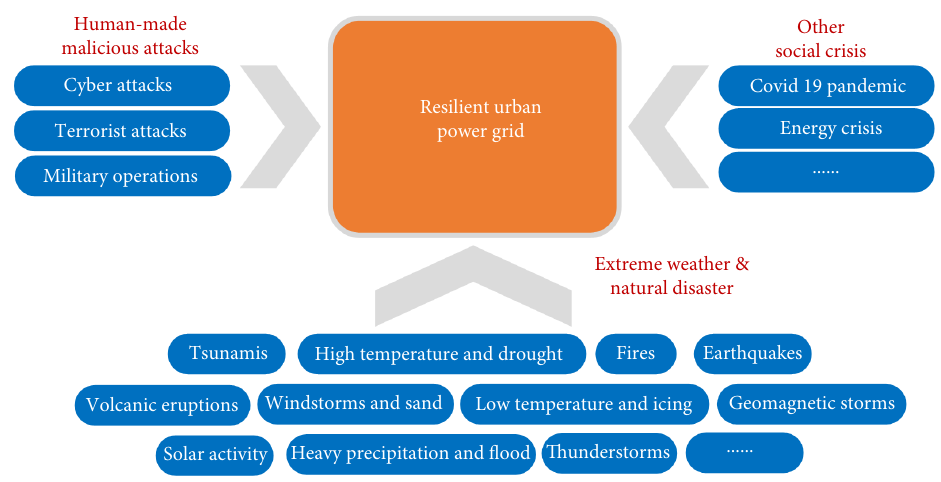
Fig. 3 Extreme events impact the resilient urban power